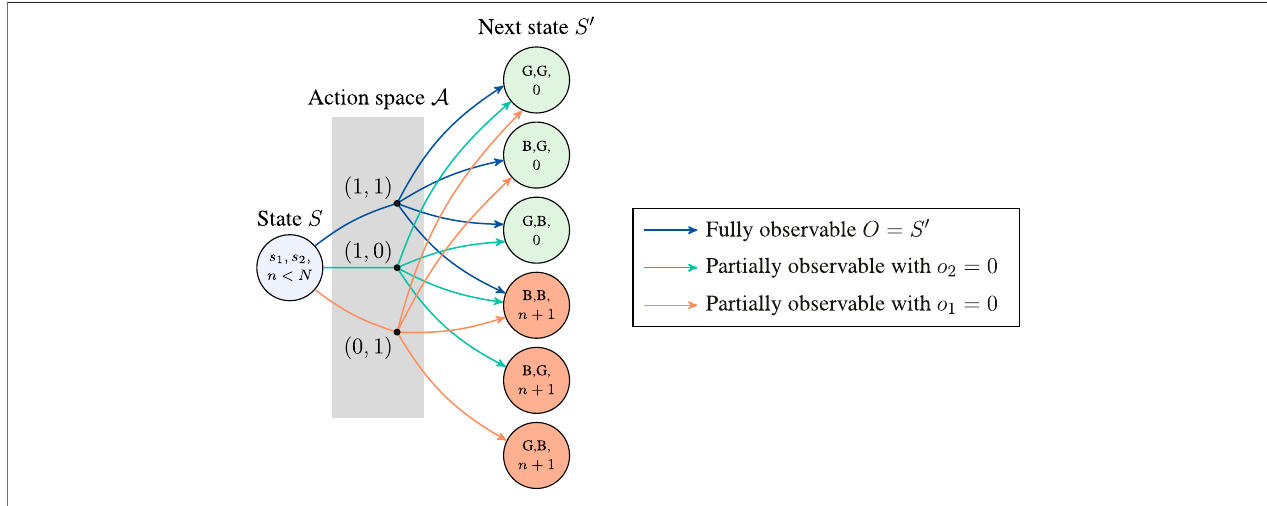
FIGURE 3 | One-step transitions from an arbitrary non-absorbing state (i.e., n < N ) for the partially observable Markov decision process (POMDP) with two interfaces.